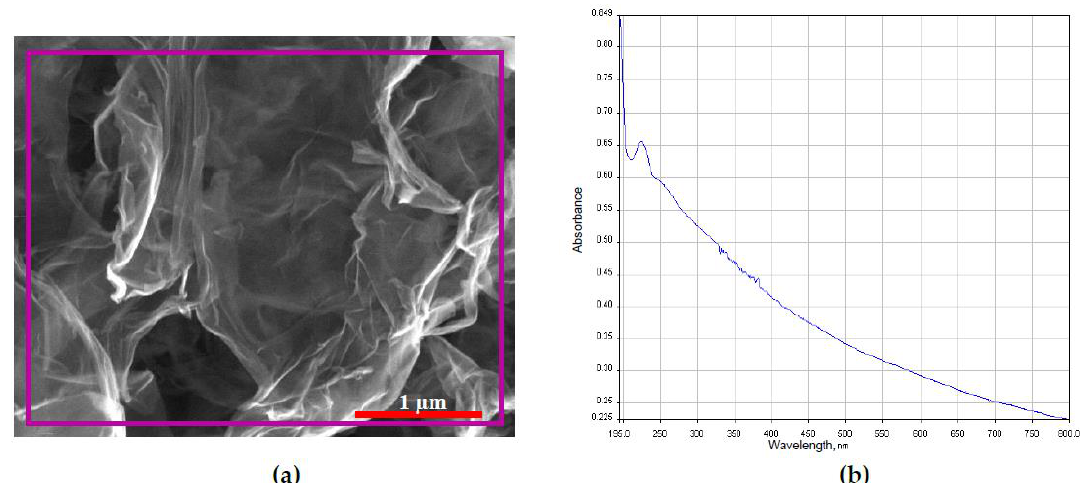
Figure 1. ( a ) FESEM image with boxed area (purple line) of which the EDX analysis performed and ( b ) UV–VIS absorption spectrum of GO. Table 1. Elemental composition of GO Element Atomic % Carbon 72.80 Oxygen 27.09 Sulfur 0.11